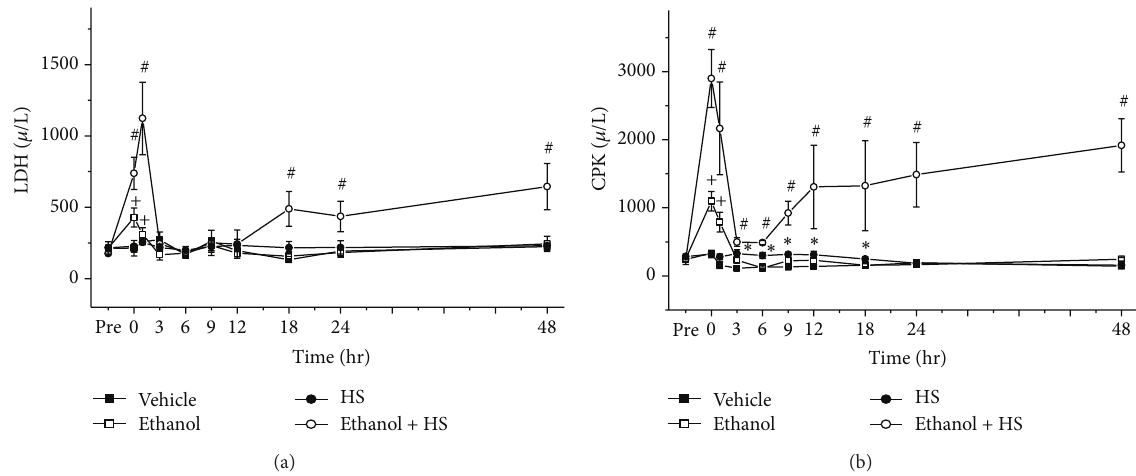
Figure 5: Changes in serum (a) lactic dehydrogenase (LDH), and (b) creatine phosphokinase (CPK) after hemorrhagic shock in rats. ∗ 𝑃 < 0.05 for the HS group compared with the Vehicle group. + 𝑃 < 0.05 for the Ethanol group compared with the Vehicle group. # 𝑃 < 0.05 for the Ethanol + HS group compared with the HS group.